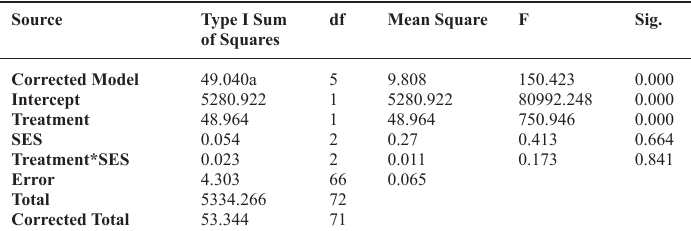
Table 4 Effect of SES on Writing Skills with the Treatment: Two way Analysis of Variance (Tests of Between-Subjects Effects) Dependent Variable: Mean of obtained scores in achievement test